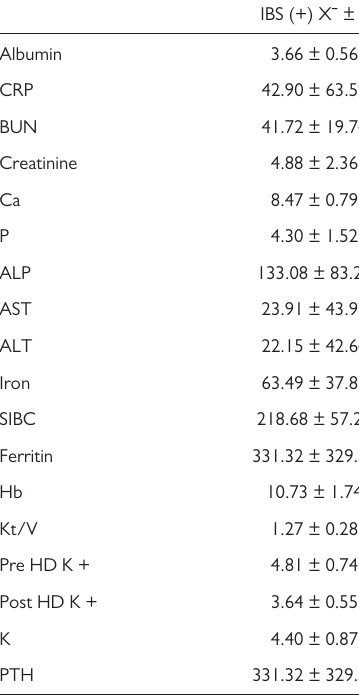
Table 3. Comparison of Laboratory Findings of Patients with and without